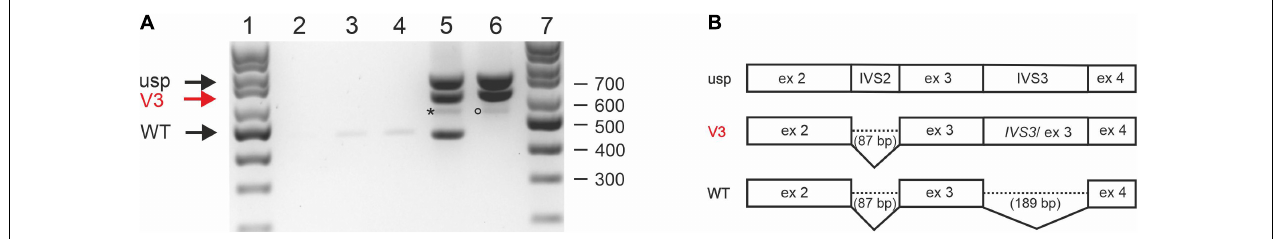
FIGURE 3 | Splicing analysis using STUB1 minigene constructs. (A) Expression studies of STUB1 minigene templates. (1) 100 bp size standard, (2) control without cDNA, (3) Chinese hamster ovary (CHO) cells mock transfected, (4) CHO cells transfected with vector pcDNA3.1+, (5) CHO cells transfected with construct pcDNA3.1- STUB1 -WT, (6) CHO cells transfected with construct pcDNA3.1- STUB1 -Mut, (7) 100 bp size standard. Black arrows indicate wild type (WT) and unspliced (usp) fragments. Retention of intron 3 is marked by a red arrow (V3; also in panel 3B). An asterisk indicates a 530 bp splice intermediate lacking intron 3 but containing intron 2 (lane 5). The rare use of cryptic splice site c.524+86 is marked by a circle (lane 6). (B) Graphical overview of detected splice